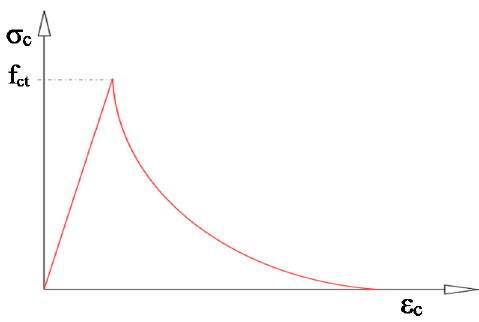
Figure 2. Exponential tension softening diagram.